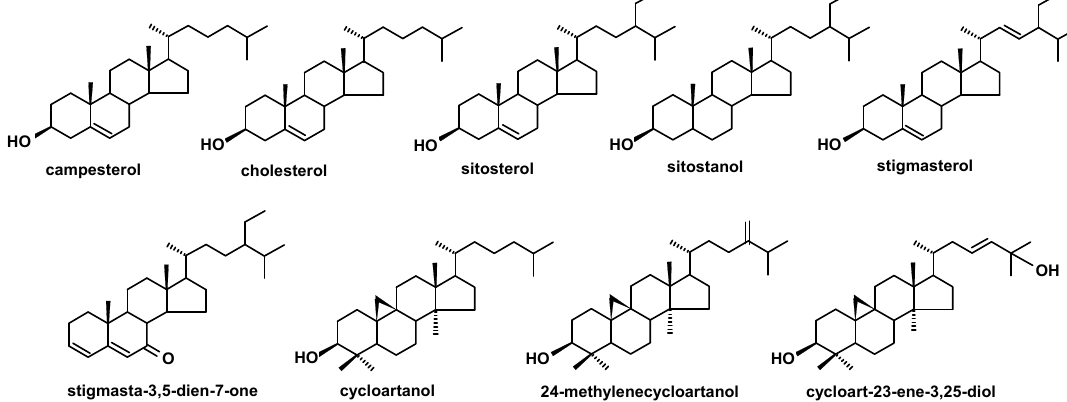
Figure 7. The structures of steroids identified in cuticular waxes of fruit analyzed in this study.